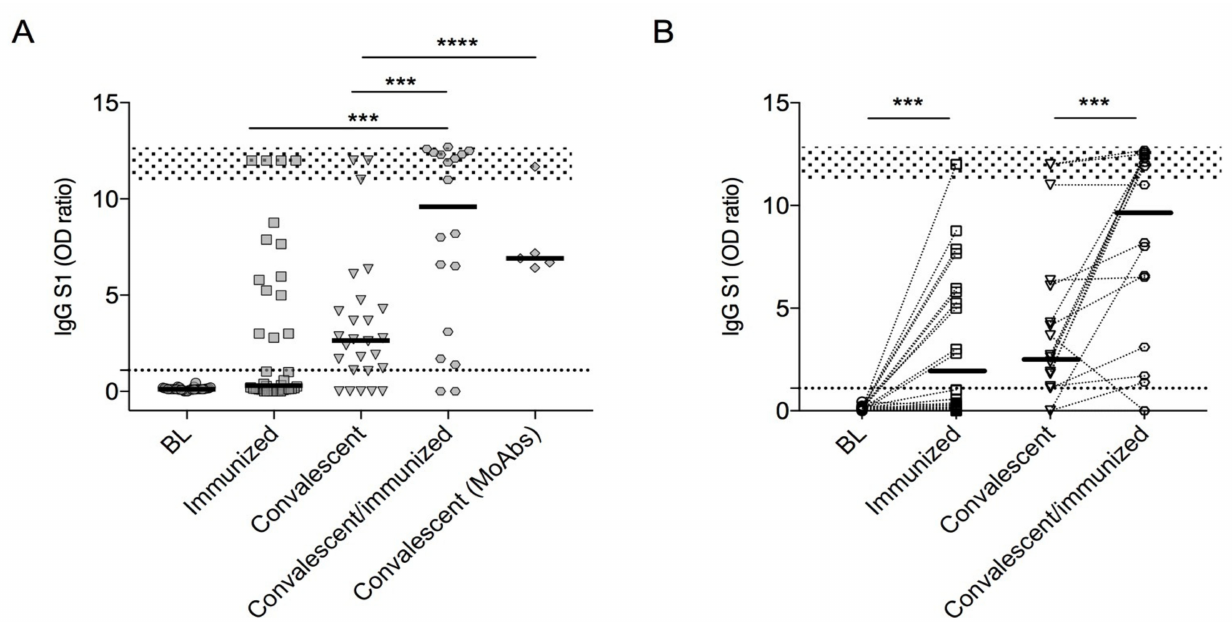
Figure 1. Spike-specific IgG levels in the CVID cohort (panel ( A )) Data are shown at baseline (BL) after immunization (immunized, n = 38), after infection (convalescent, n = 34), and after immunization in convalescents (convales- cent/immunized n = 20). Data from monoclonal antibodies (MoAbs, n = 5) recipients are shown separately. Changes in individual data points of spike-specific IgG antibodies from BL to post-immunization and from SARS-CoV-2 recovery to post-immunization are shown in panel ( B ). The positive cut-off values are represented by a dashed line. For each group, medians are plotted as horizontal bars. The dotted area represents the IQR range in healthy donors (HD) after immuniza- tion as previously reported [26]. **** p < 0.0001; *** p < 0.001; p -value represents the level of significance by two-tailed Mann–Whitney U-test (immunized vs convalescent/immunized and convalescent vs convalescent (MoAbs)) or by Wilcoxon matched-pairs signed-rank test (BL vs immunized and convalescents vs convalescents/immunized). Abbreviation: BL